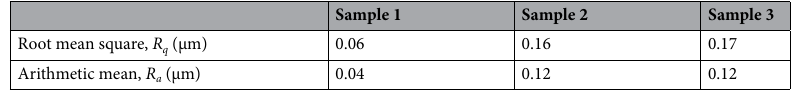
Table 4. Surface roughness parameters obtained from AFM scanning the surface of fibers of the three samples.